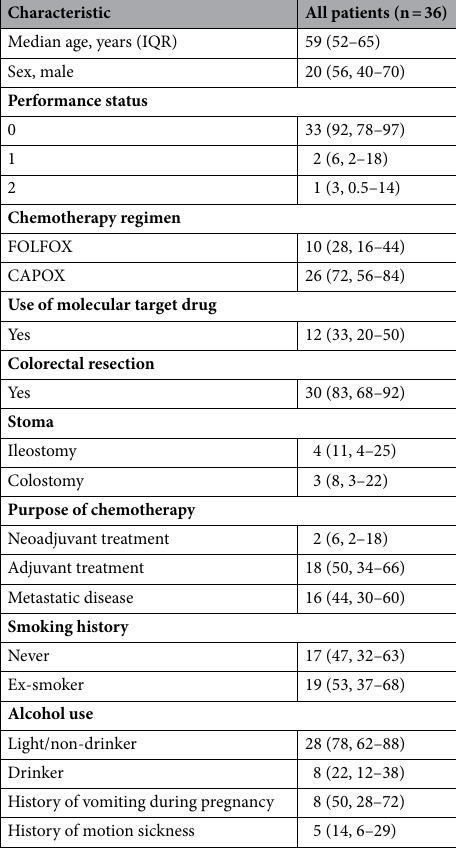
Table 3. Characteristics of patients included in the CINV analysis. IQR interquartile range. Data are given as n (%, confidence interval) unless otherwise noted.